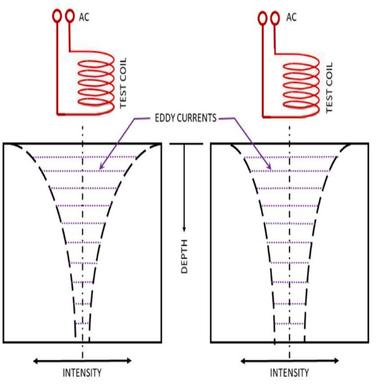
(A) Relative magnitude and distribution of eddy currents in good or poor conductors, (B) relative magnitude and distribution of eddy currents in conductive material of high or low permeability.